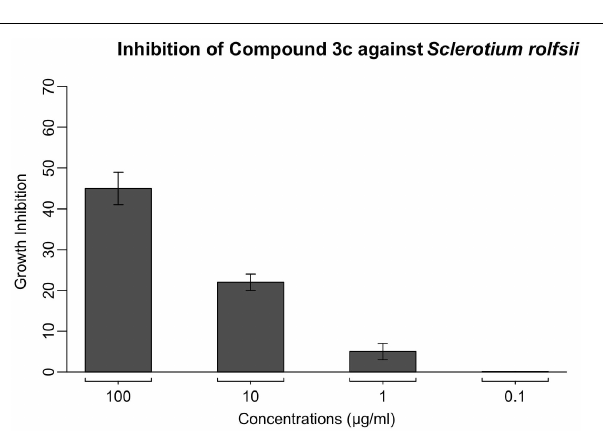
FIGURE 1 | The inhibitory effect of lead compound 3c against S. rolfsii was measured using PDA assay at concentrations of 0.1, 1, 10, and 100 µ g/ml. Points indicate means, and bars indicate SD ( n =